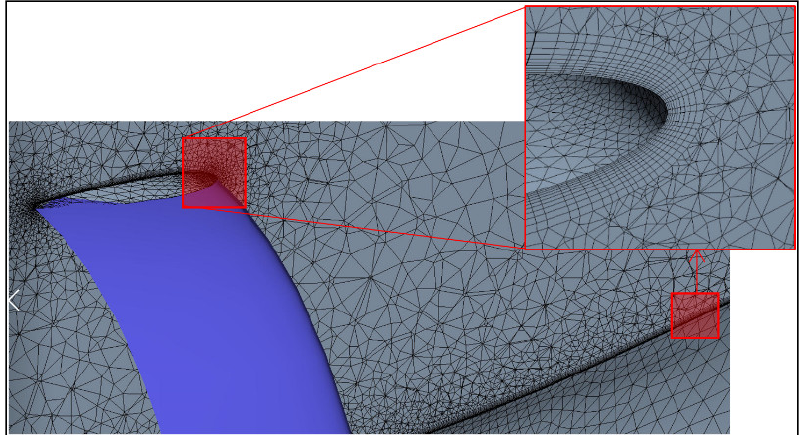
Figure 11. Prismatic boundary layer on both the fuselage and the duct surfaces.